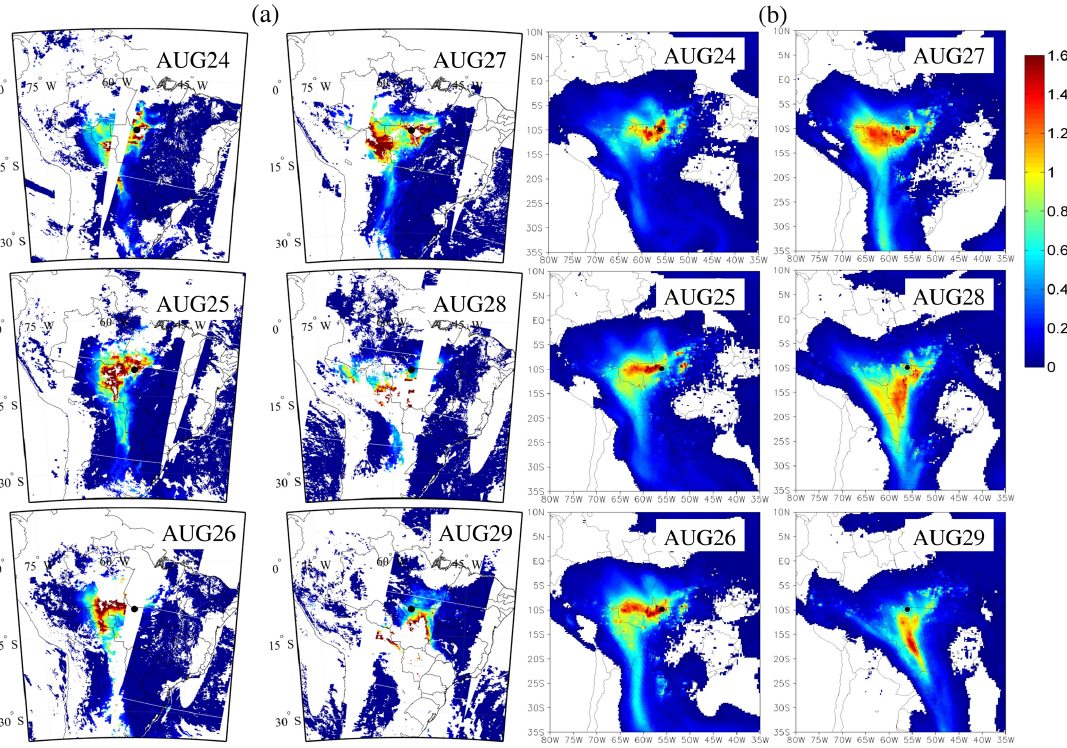
Fig. 5. Comparison between spatial distributions of aerosol optical depth at 550nm (AOD 550nm ) retrieved by (a) MODIS aboard Terra satellite and modeled by (b) CCATT-BRAMS from 24 to 29 August, period when major discrepancies occurred between the model results and AERONET AOD retrievals.